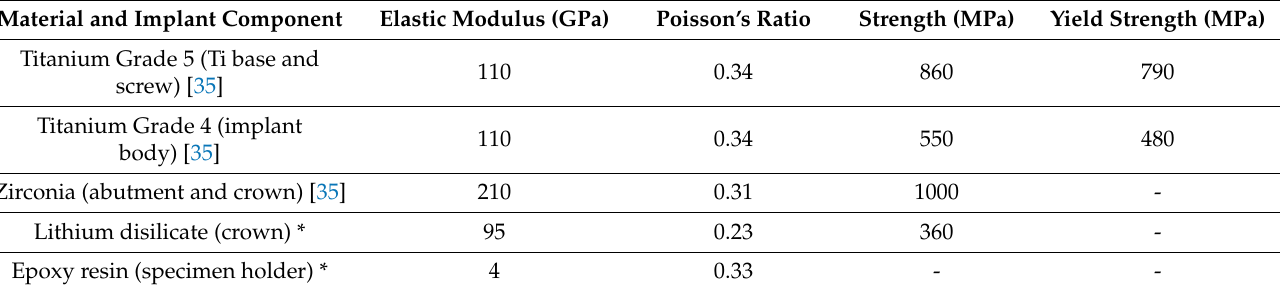
Table 1. Material properties used in the finite element models.